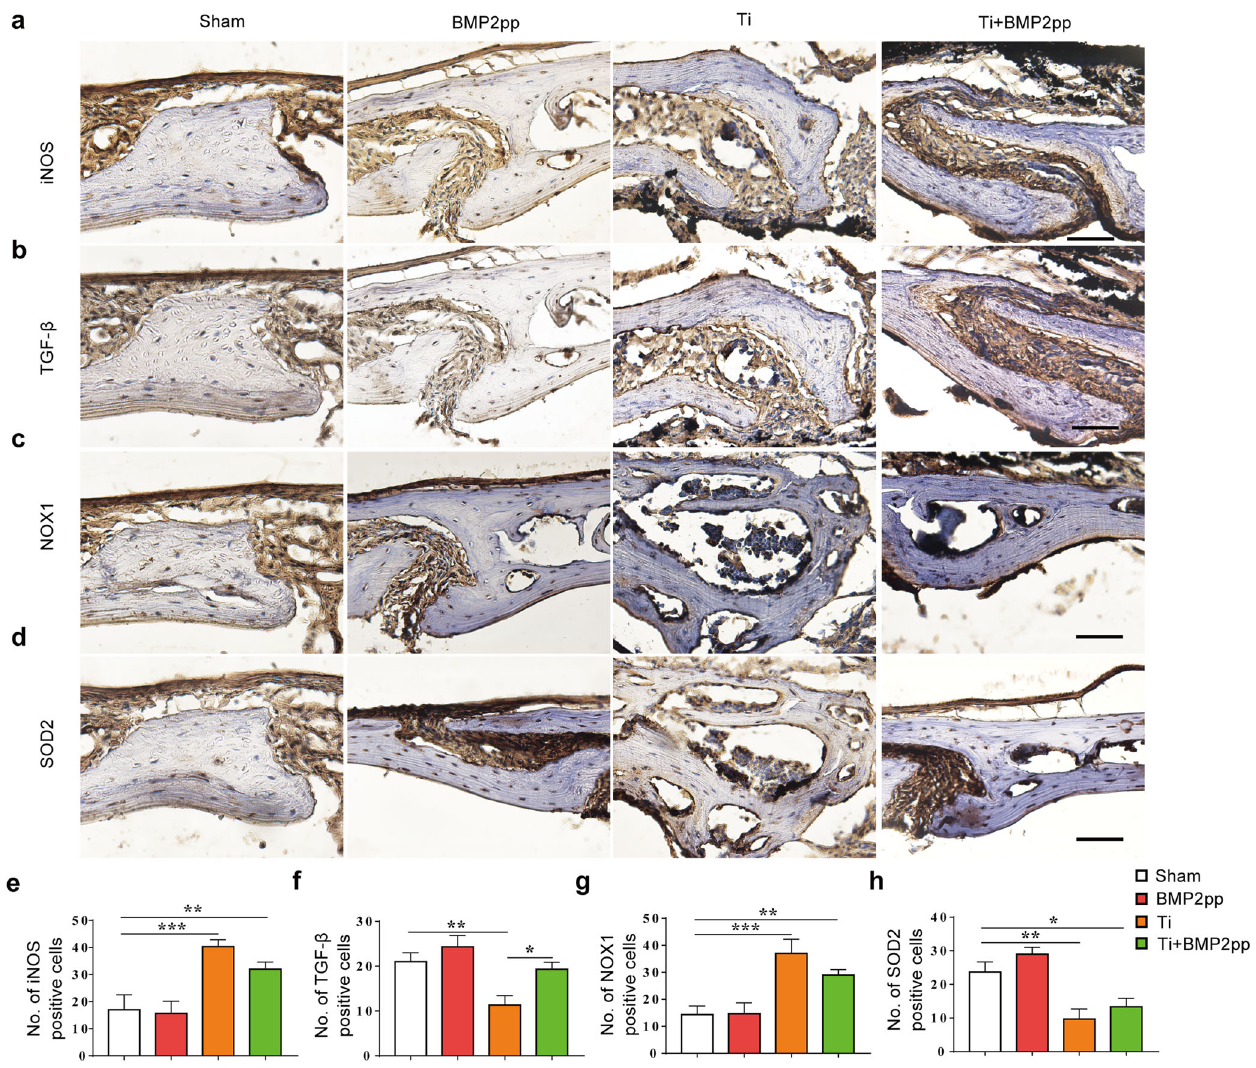
Fig. 7 BMP2pp promoted M2 polarization of macrophages and enhanced antioxidant capacity in the calvarial bone caused by Ti particles in mice. Representative images of immunohistochemical staining of a iNOS, b TGF- β , c NOX1, and d SOD2. scale bars: 50 μ m. The number of e iNOS, f TGF- β , g NOX1, and h SOD2 positive cells, n = 8. All the data are presented as the average ± standard deviation